Question: Which kind of chart has been used to present this data?
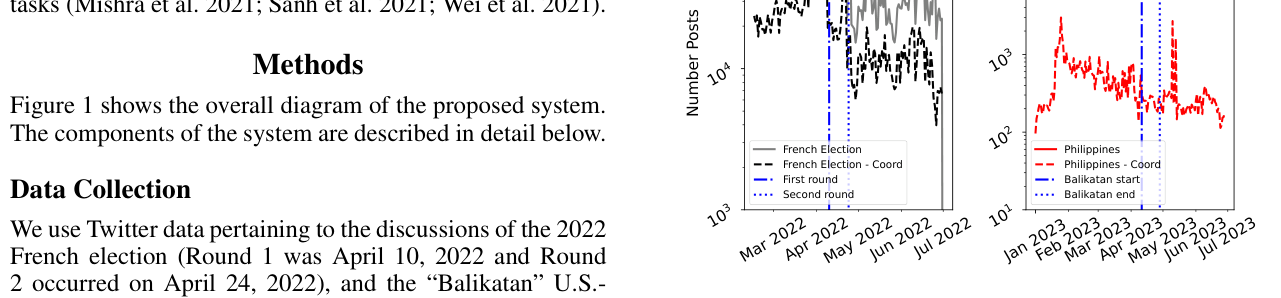
Answer: line